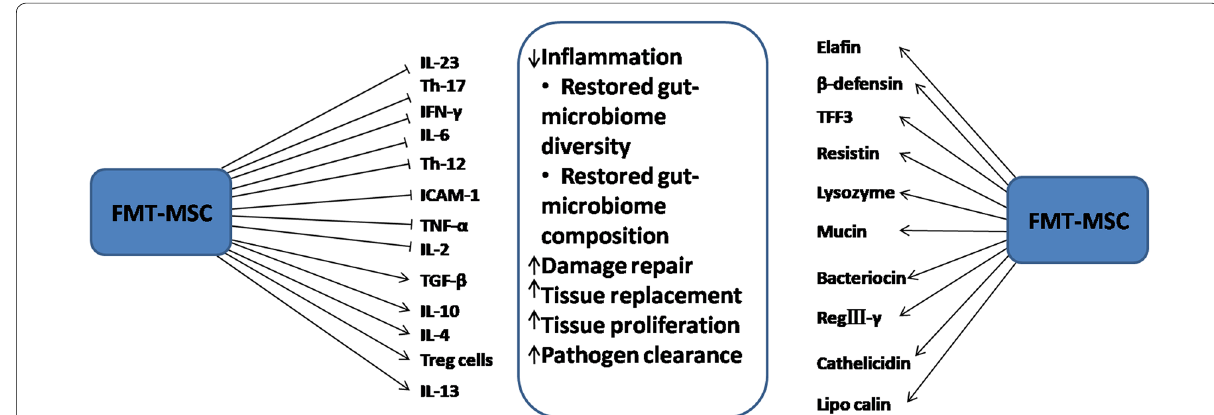
Fig. 3 The combined effects of FMT–MSC secretomes in attenuating IBD. Several immunomodulatory factors are found in the inflammatory environment. With the quest to attenuate IBD, the administered MSCs and FMT regulate these modulators to inhibit inflammation and restore gut function. In the event of pathogenic bacterial colonization, a number of bactericides are expressed to eradicate